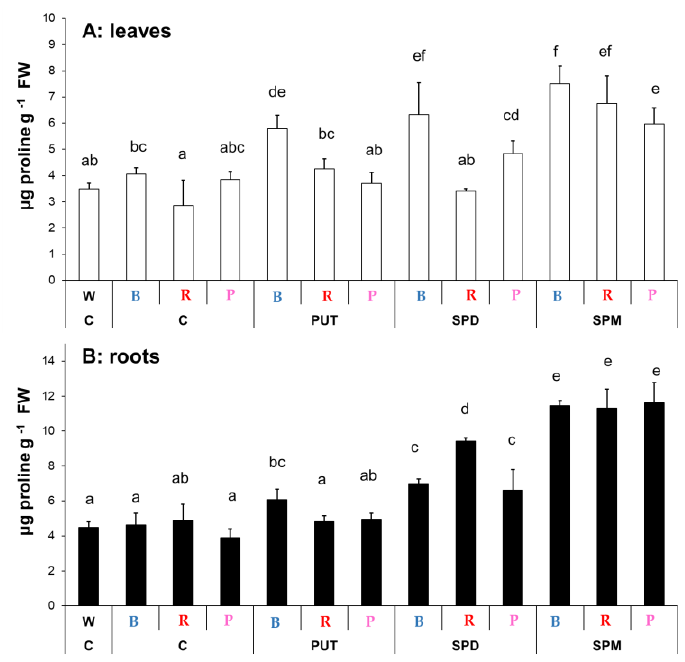
Figure 2. Changes in proline contents in the leaves ( A ) and roots ( B ) of plants grown under different light regimes (white light: W, blue light: B, red + far-red: R and the combination of blue and red + far-red, pink: P) treated with or without polyamines (control: C, putrescine: PUT, spermidine: SPD and spermine: SPM). Values are means ± SD ( n = 3). Different letters indicate statistically significant differences at p < 0.05 level, using Duncan’s post hoc test.